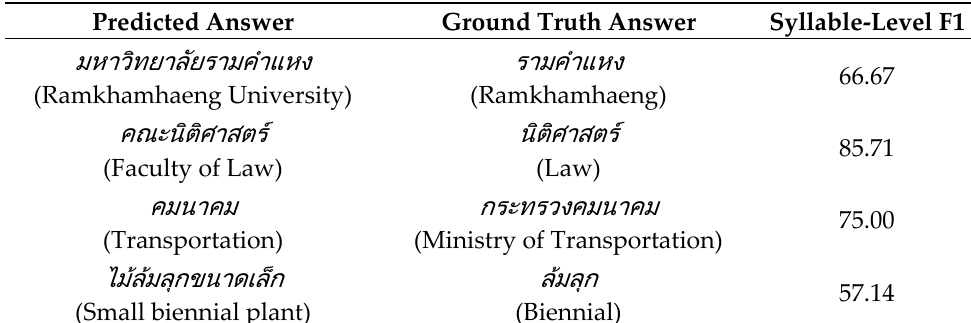
Table 7. Examples of the predicted answer and the ground truth answer that show the syllable-level F1; all results get 0 of the word-level F1.